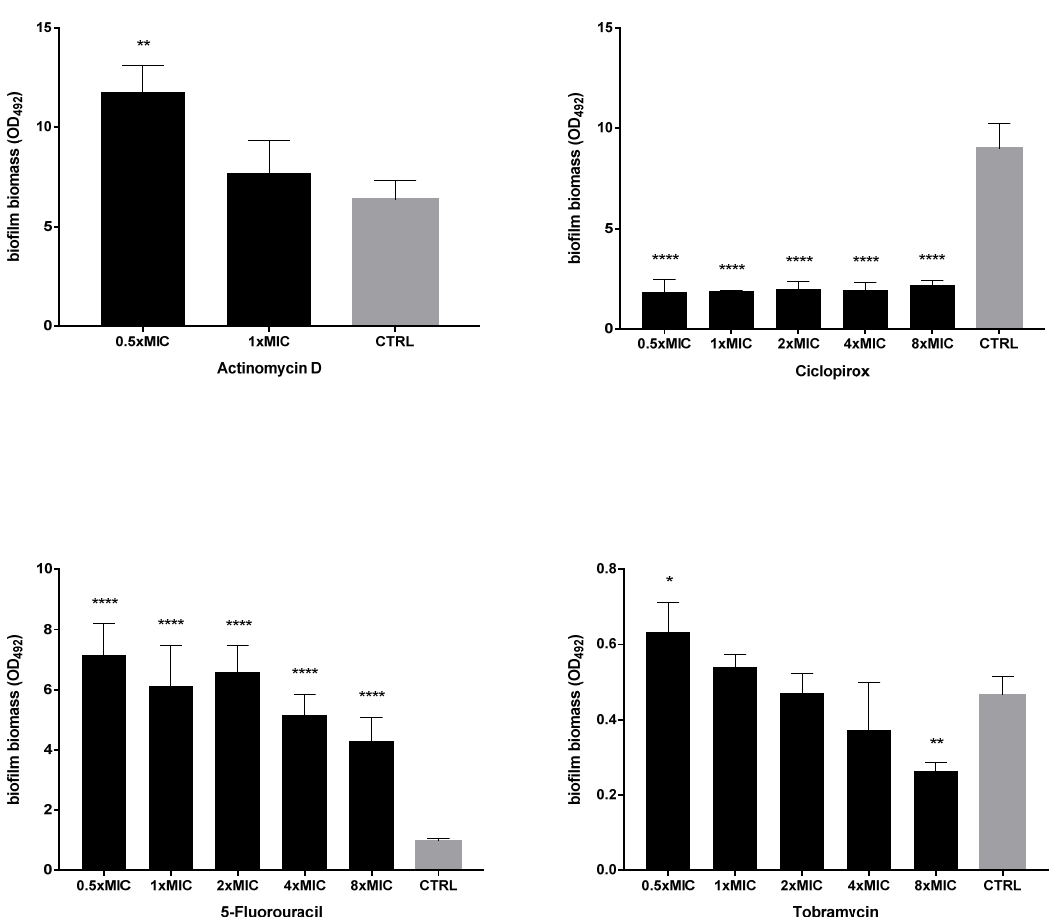
Figure 5. Dispersal activity against preformed biofilms by P. aeruginosa Pa7. The efficacy of actino- mycin D, ciclopirox, and 5-fluorouracil to disperse 24 h mature P. aeruginosa Pa7 biofilms was assessed, comparatively to tobramycin, using crystal violet assay. P. aeruginosa Pa7 was chosen as representative of tobramycin-susceptible strains. Each drug was tested at 0.5x and multiples of MIC value. Results were expressed as mean + SD of the residual biofilm biomass (OD 492 ) after 24 h of exposure. Control samples (CTRL) were not exposed to the drug. Statistical significance at ordinary one-way ANOVA + Holm–Sidak’s multiple comparisons post-test: * p < 0.05, ** p < 0.01, **** p < 0.0001 vs. CTRL.